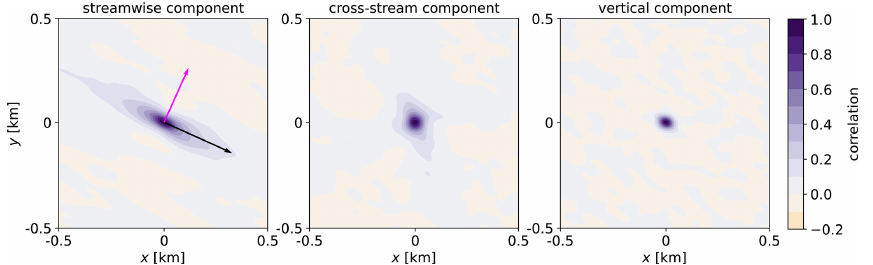
Figure 5. Contour plots of the spatio-temporal average of spatial correlation for the three turbulence components for the 15min interval starting at 2:40Z. The interval-mean along-wind and crosswind directions are indicated by the black and magenta arrows, respectively. The spatial correlation of the streamwise component is stretched in the direction of the wind (mostly towards the southeast, black arrow), while other components show no clear preferential